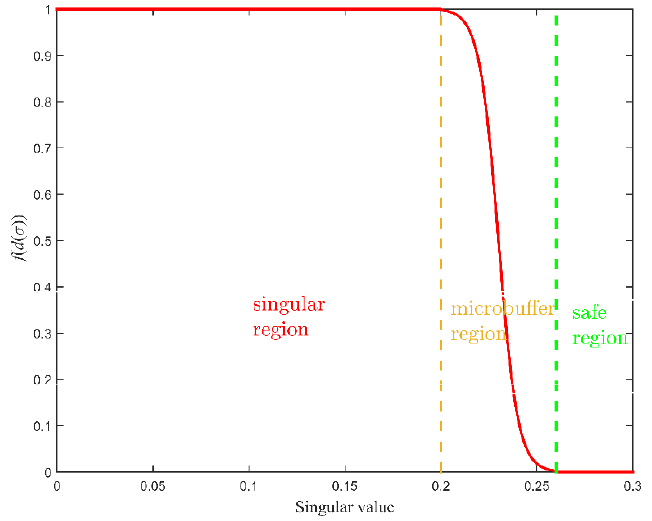
 and  . The exam- b b